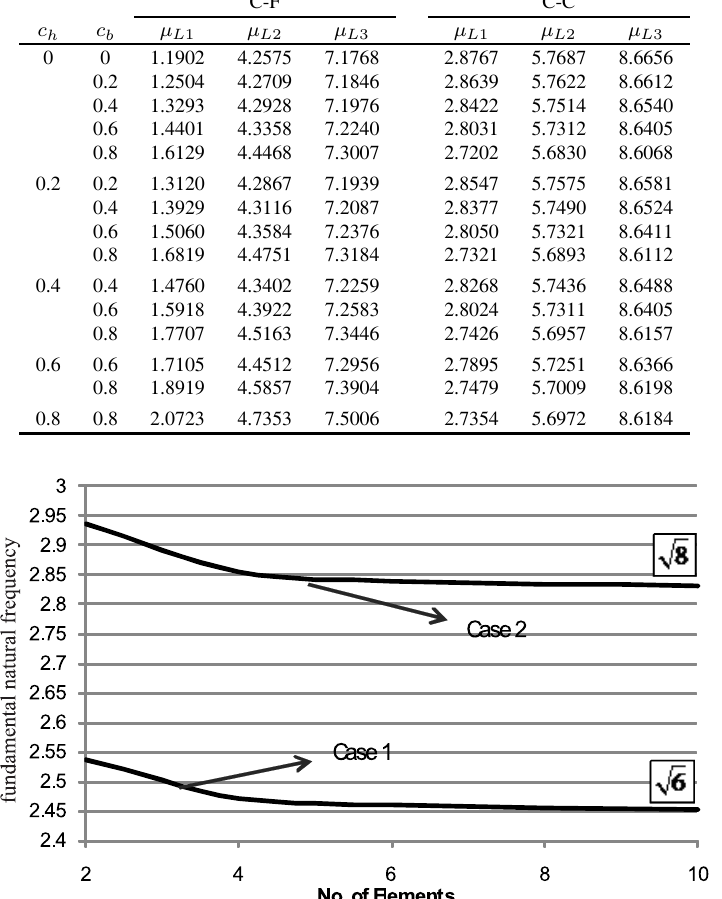
Fig. 2. Convergece of the present element in determination of the fundamental longitudinal frequency of a unit length C-F inhomogeneous rod. Case 1: ρ ( X ) = 1 , E ( X ) = 2 + 2 X − X 2 ; Case 2: ρ ( X ) = 1 + X, E ( X ) = 13 3 + 13 3 X + 1 3 X 2 − X 3 . (Results in squares are exact ones reported in Candan and Elishakoff